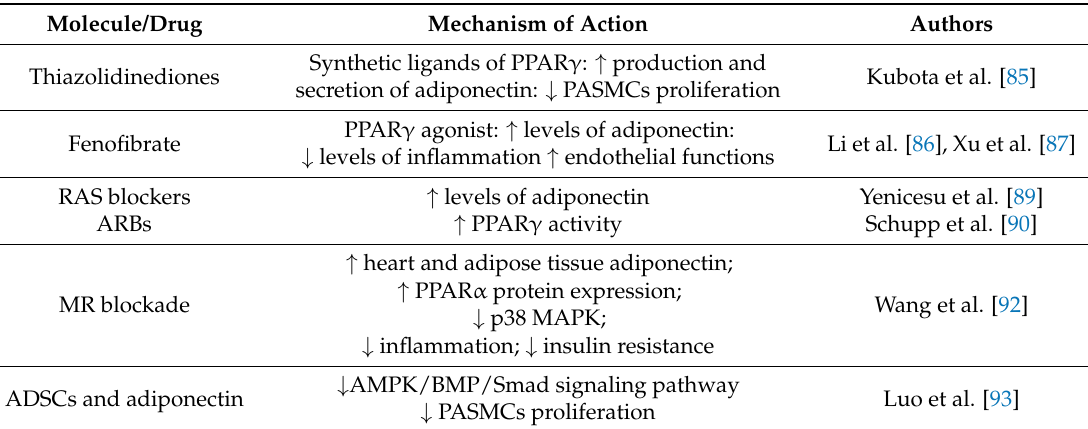
Table 1. Adiponectin modulation in pulmonary